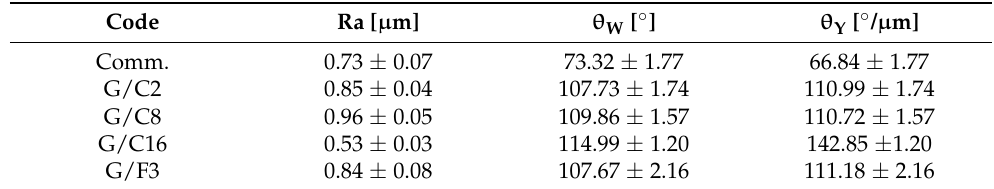
Table 2. Roughness values of Ra and comparison of the contact angles of Wenzel ( θ W ) and Young ( θ Y ) of the coatings.